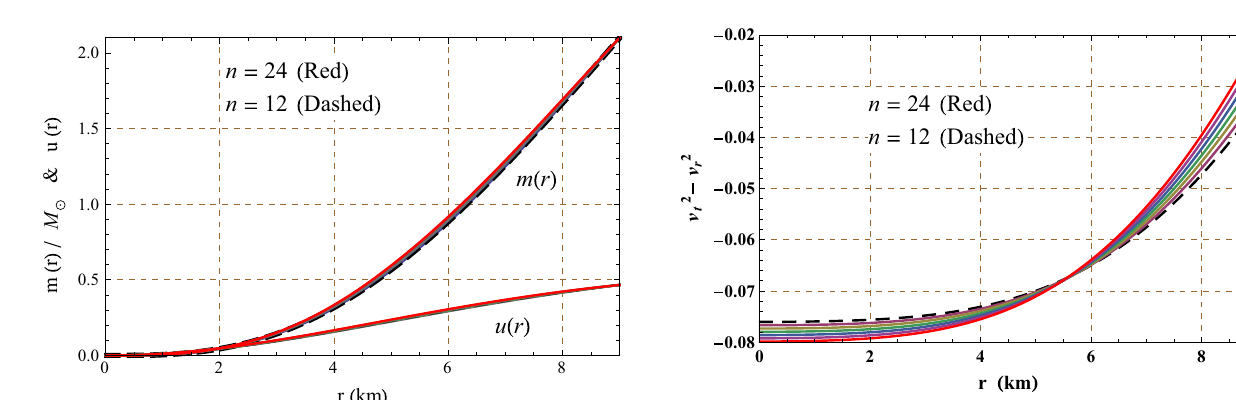
Fig. 7 Variation of sound speed with radial coordinate for the param- eters given in Table 1